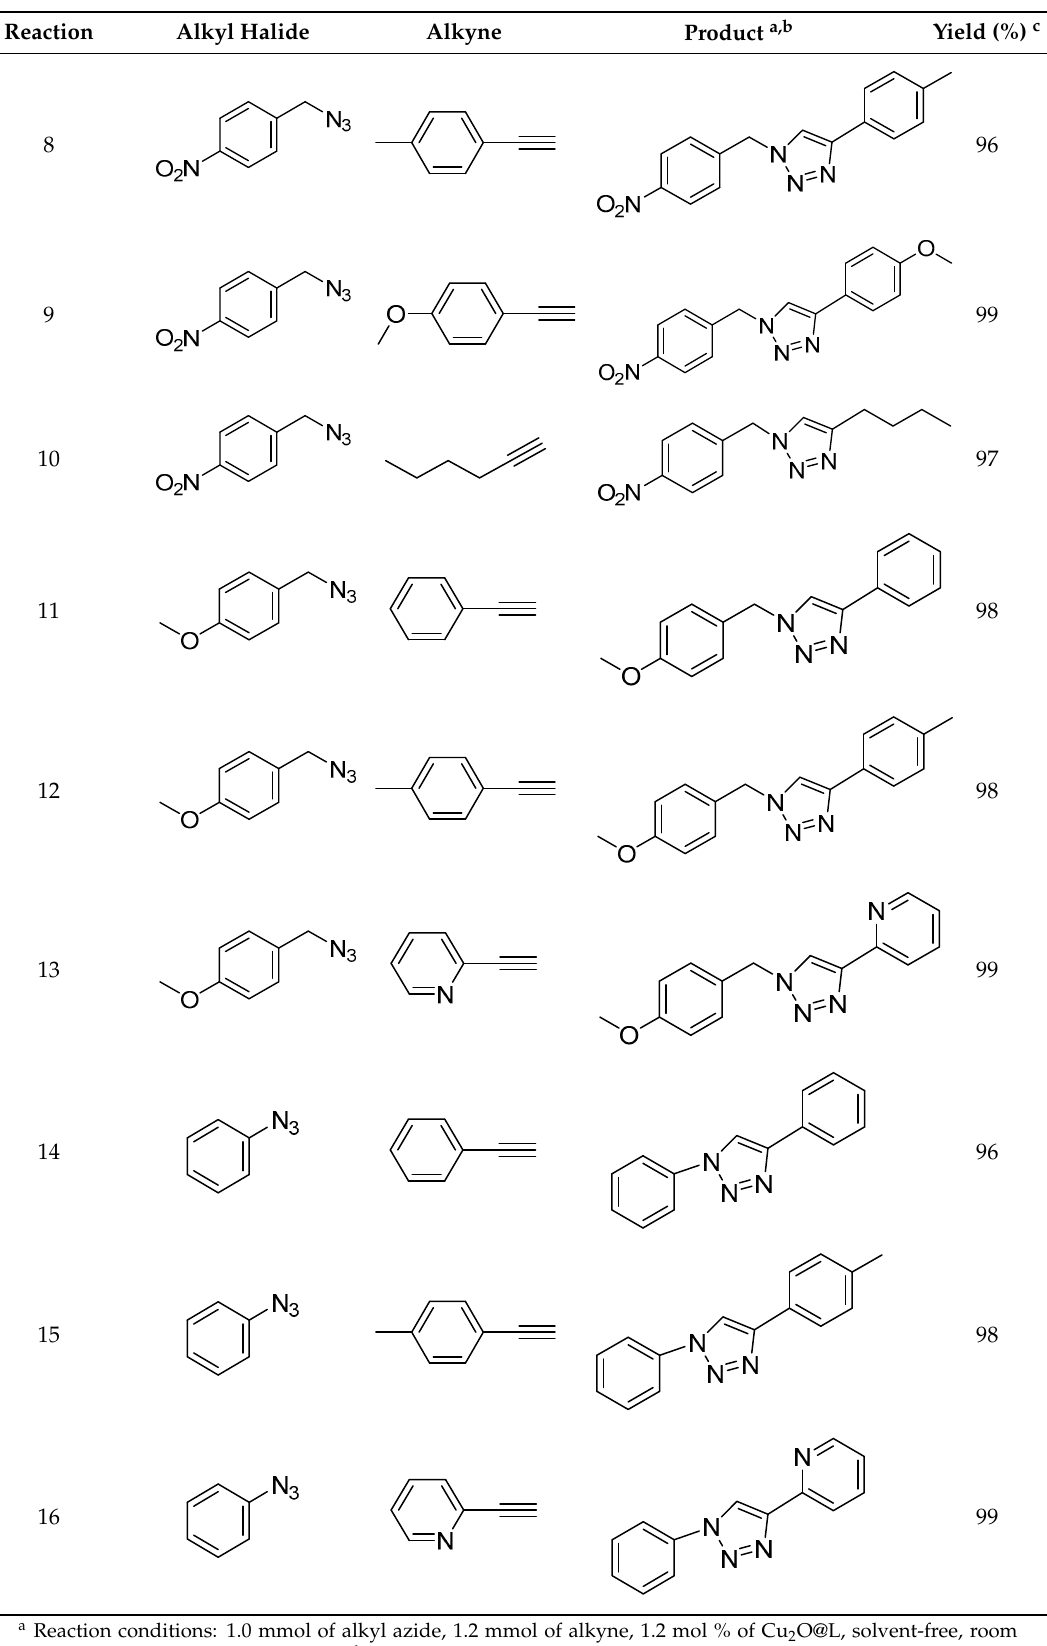
Table 1. Huisgen “click” reactions using Cu 2 O@L.